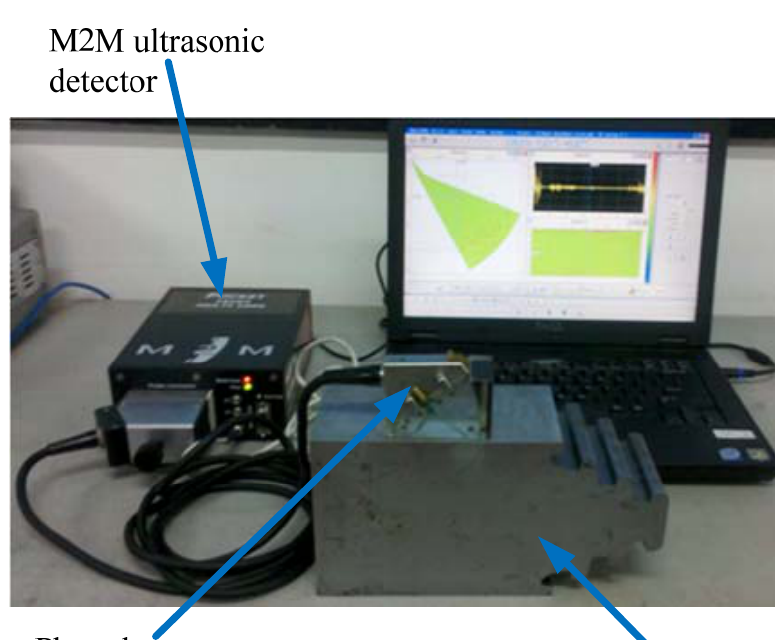
Figure 1. Data collection